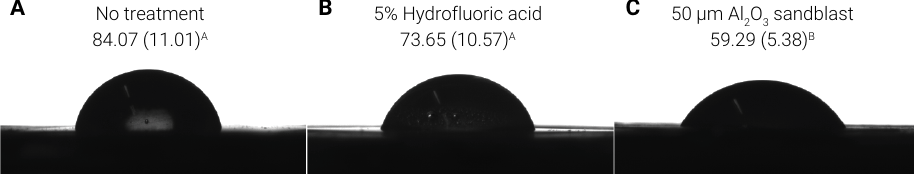
Figure 1. Images and means ± SD (in degrees) of contact angle measurements of surfaces subjected to the following conditions: no treatment (A); 5% hydrofluoric acid etching for 60 s (B); sandblasting with 50 µm alumina particles (C). Different superscript letters indicate statistically significant differences (Kruskall-Wallis and Dunn’s tests ( P < 0.05)